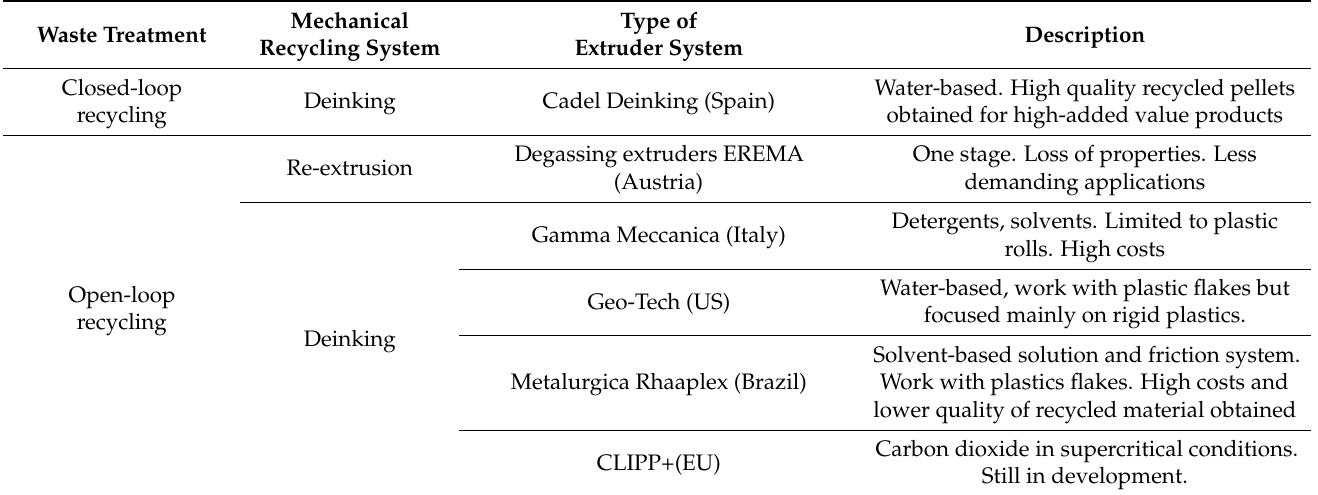
Table 4. Summary of mechanical recycling and deinking process of post-industrial monolayer waste films [3].